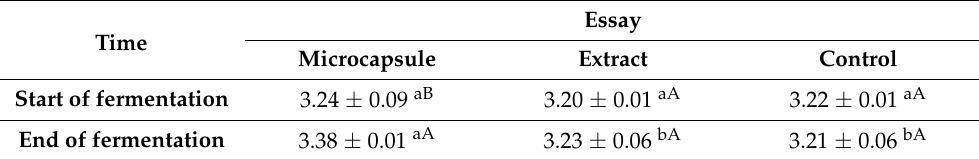
Table 3. Beverage viscosity at the beginning and end of fermentation.